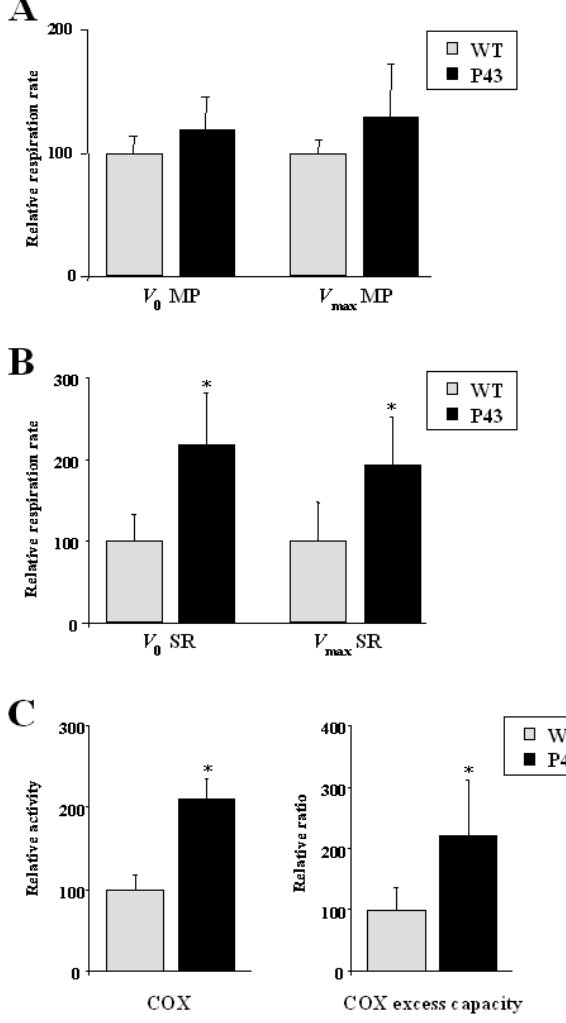
Figure 3. p43 overexpression increases mitochondrial respira- tion. (A–B) Relative respiration rate in permeabilized gastrocnemius muscle fibers from transgenic mice of the 86 line compared to wild-type animals at 2 months of age (n=5 each group). Respiration parameters were recorded at 25 u C using a Oroboros oxygraph. Resting respiration ( V 0 ) was initiated in the presence of complex I (5 mM malate and 5 mM pyruvate) or complex II substrates (10 mM succinate and 2.5 m M rotenone), and maximal ADP-stimulated respiration was measured with one addition of saturating ADP concentration (1 mM)( V max ). MP: malate and pyruvate; SR: succinate and rotenone. *p , 0.05. (C) Relative COX activity and excess COX capacity in permeabilized gastrocnemius muscle fibers from transgenic mice of the 86 line compared to wild-type animals at 2 months of age (n=5 each group). COX activity was measured after addition of ascorbate and TMPD. COX: cytochrome c oxydase; Excess COX capacity: [ V max (COX) 2 V max (malate + pyruvate)]/ V max (malate + pyruvate). *p , 0.05.